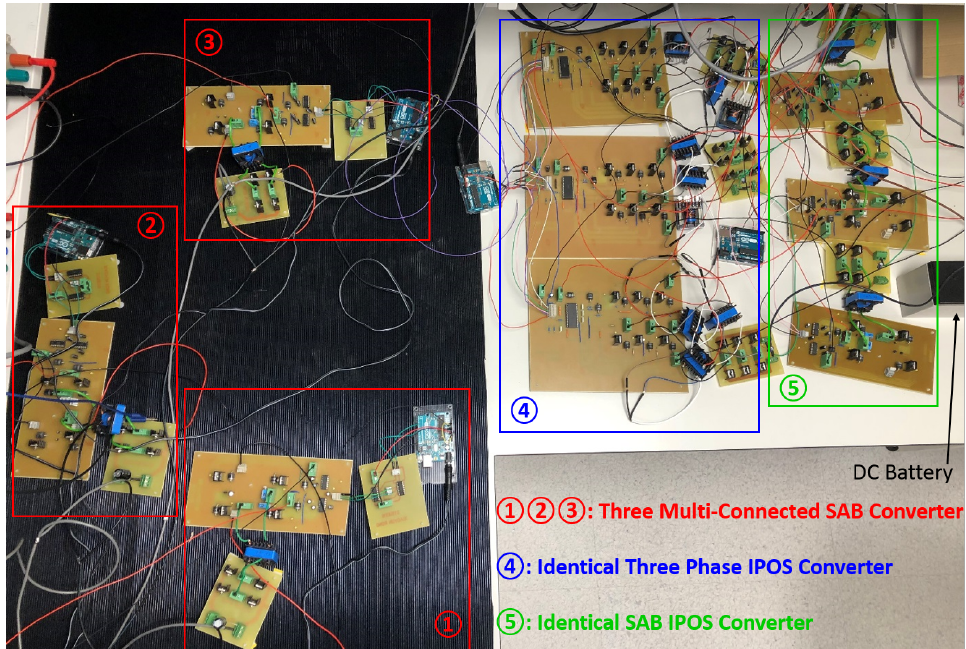
Figure 10. The prototype of the downscaled and simplified multi-terminal DC